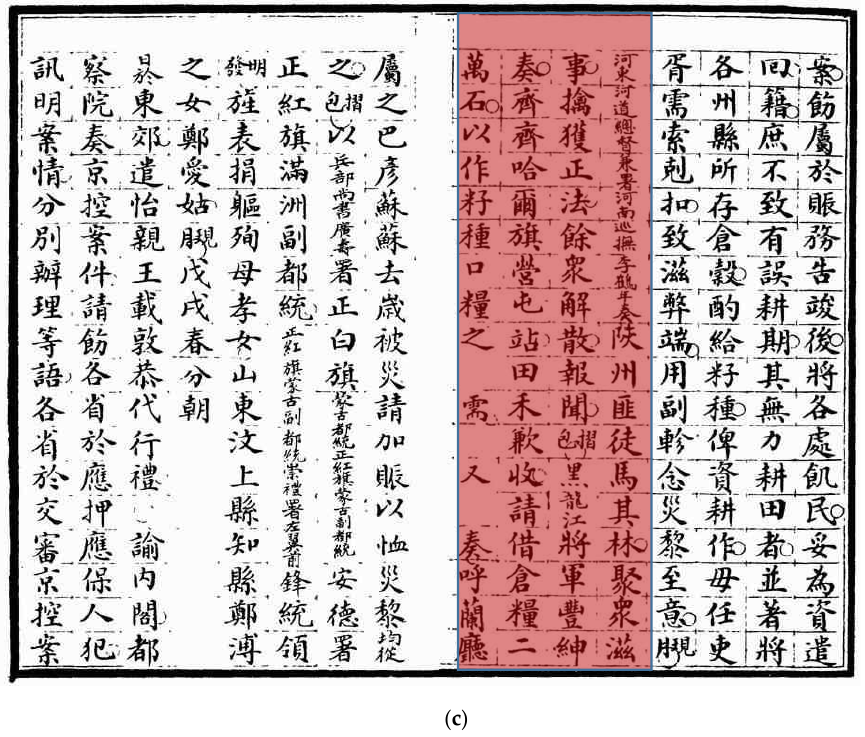
Figure 3. Historical records related to the North China Famine of 1876–1879 ( a ) is from Shenbao, about the famine-related migration; ( b ) is from Qing Shi Lu, about the allocation of money and grain; and ( c ) is also from Qing Shi Lu, about social